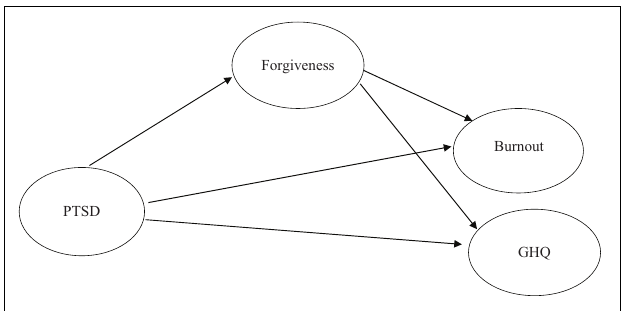
FIGURE 1 | Hypothesized model with forgiveness mediating PTSD from past trauma, burnout, and mental